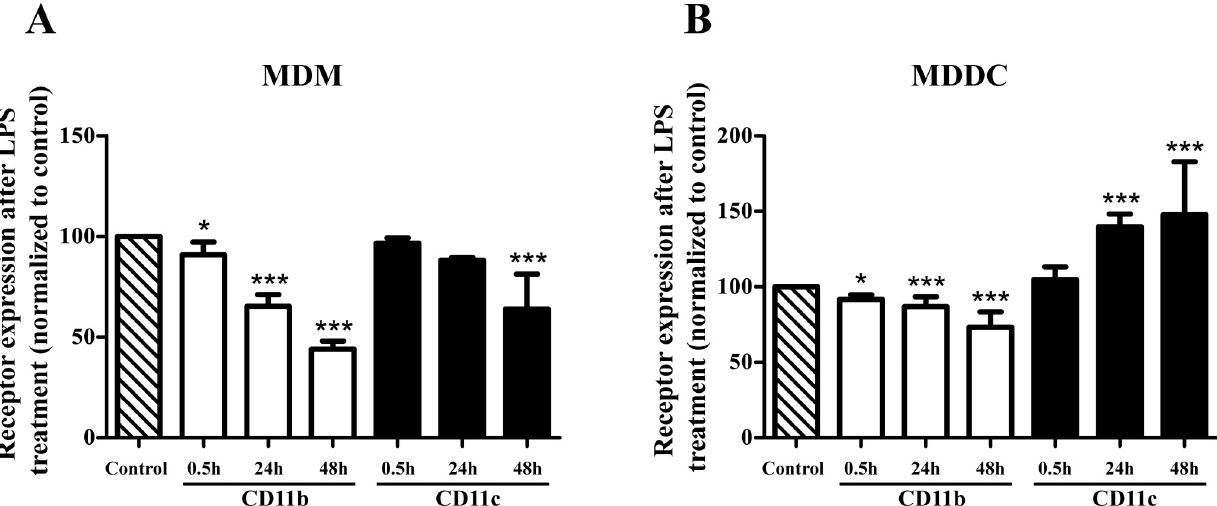
Fig 1. Changes in the expression of CR3 and CR4 after LPS induced activation. The surface expression of CR3 and CR4 was measured at different time points by flow cytometry. The effect of 100 ng/ml LPS treatment was compared to the appropriate untreated control sample at each time point, shown as 100%. For MDMs (A) results of 3 donors (mean ± SD), for MDDCs (B) 4 donors’ results (mean ± SD) are shown. Two-way ANOVA with Bonferroni post-test was used to determine significant differences compared to control, � = p < 0.05; �� = p < 0.01; ��� = p <